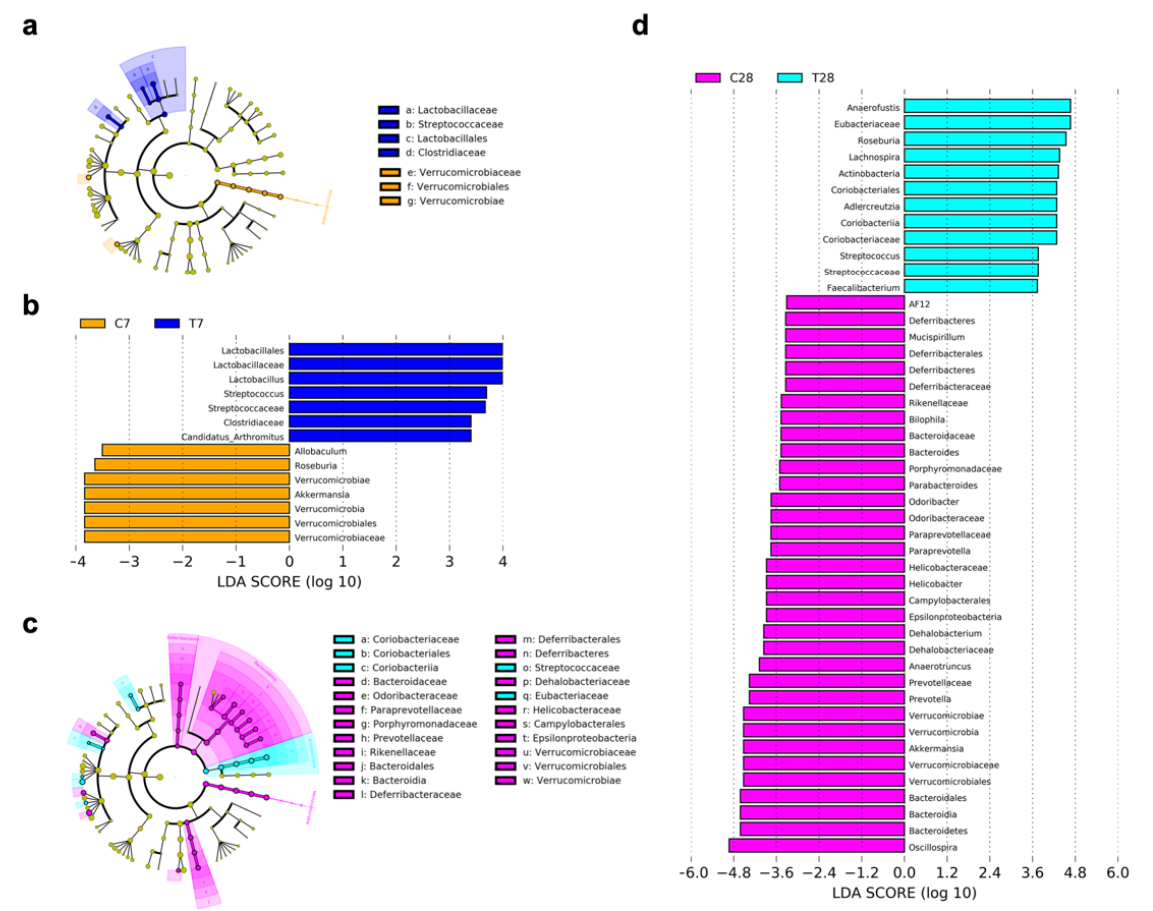
Figure 9. Linear discriminant analysis effect size of gut microbiota. Cladogram of LEfSe at 7 days ( a ) and 28 days ( c ) post-TBI. LDA score of LEfSe at 7 days ( b ) and 28 days ( d ) post-TBI.